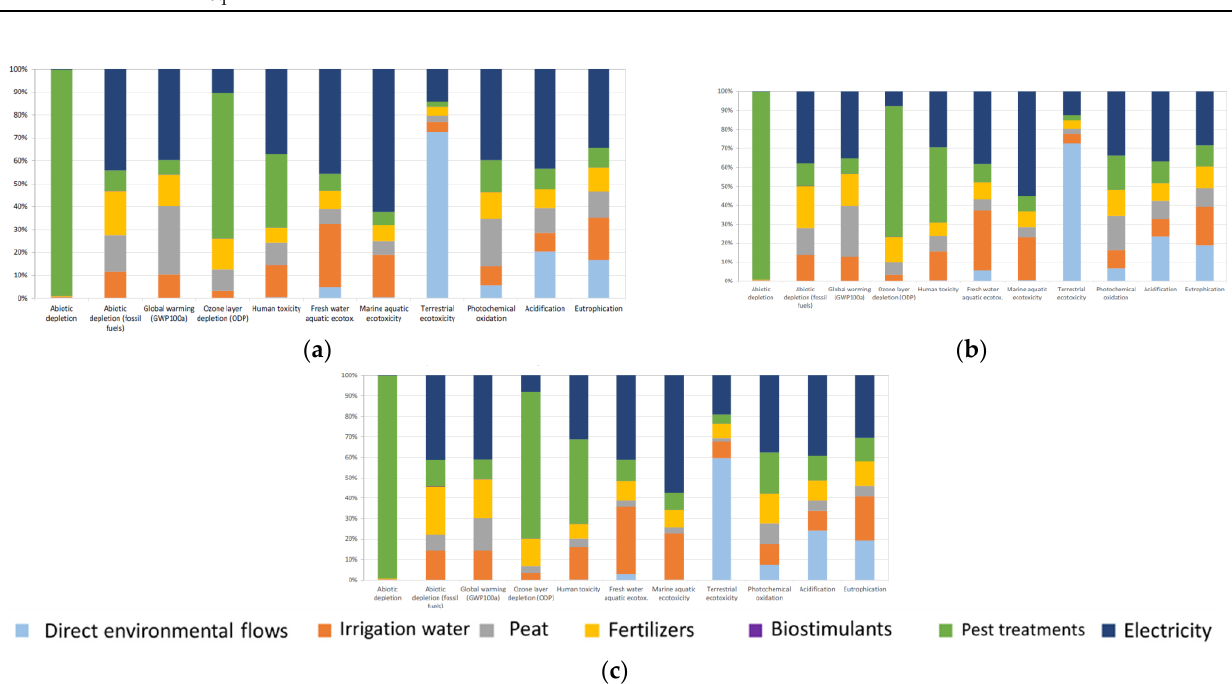
Figure 3. Characterization stage of the impacts of 1 kg of lemons for a specified methodology (CML- IA baseline) for S25 ( a ); S50( b ); and S75( c ) culture media. Relative values. Direct environmental flows (elementary flows) represent atmospheric emissions (NH 3 and NO 2 ) and discharges to the ground (metals contained in drainage water). Long-term emissions (> 100 years) are included, and the infrastructure processes are excluded.